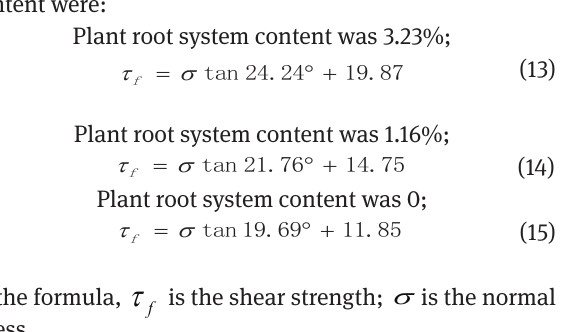
Figure 11: Trend of shear strength of dry red soil with different plant root contents.